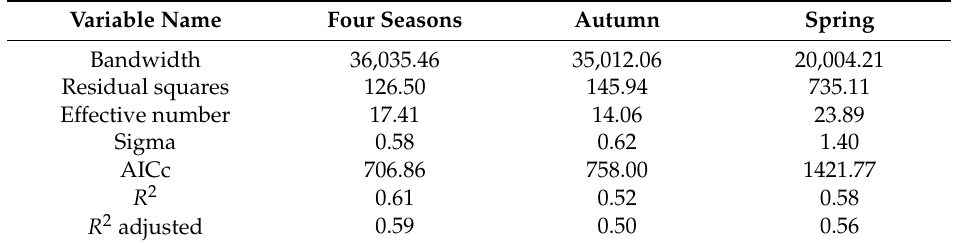
Table 4. Results of GWR (geographically weighted regression) of pooled four seasons, autumn and spring means infestation with different environmental factors.